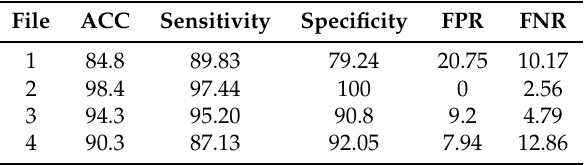
Table 1. SVM-subsystem performance in stopping the stimulation.